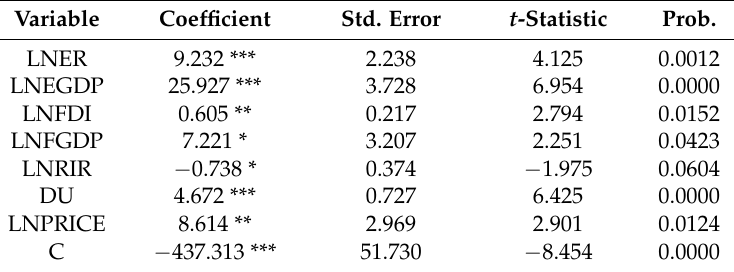
Table 8. Long-run estimates.